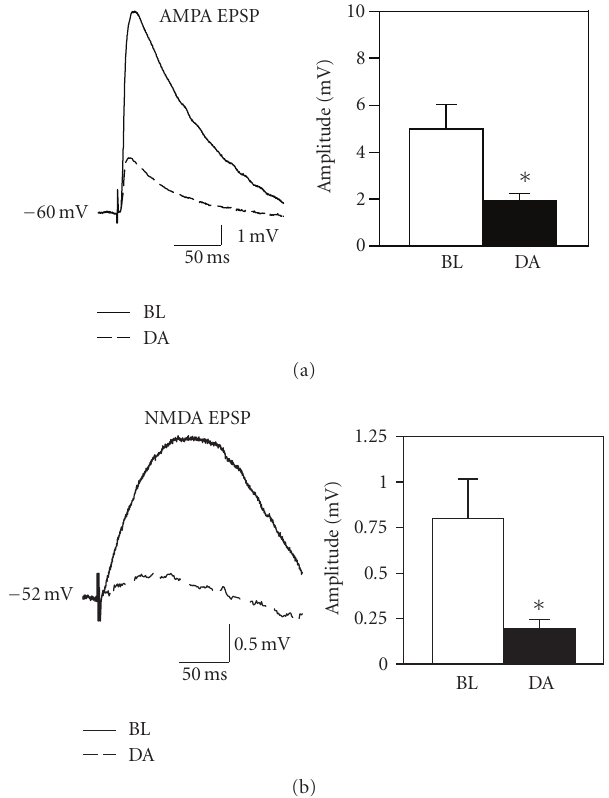
Figure 3: Dopamine suppresses the amplitude of both AMPA- and NMDA receptor-mediated components of EPSPs. (a) AMPA- mediated EPSPs recorded in the presence of APV and bicuculline were suppressed by 50 μ M dopamine. Averaged traces show EPSPs recorded before (BL) and after (DA) dopamine application, and group data are shown at right. (b) Isolated NMDA receptor- mediated EPSPs recorded in the presence of CNQX and bicuculline are also suppressed by a high concentration of dopamine. Group data show a consistent suppression of the small isolated NMDA